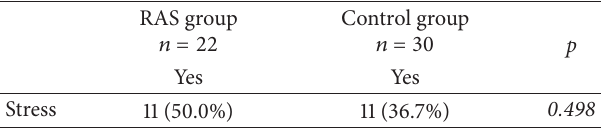
Table 3: Prevalence of stress obtained through Lipp’s Inventory of Stress Symptoms for Adults (LISS) in the RAS and control